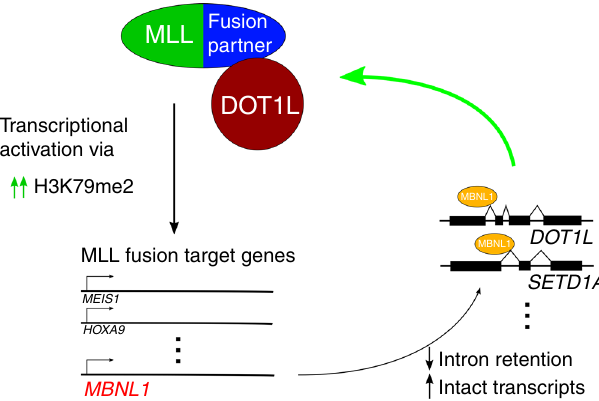
Fig. 8 Working hypothesis for the role of MBNL1 in MLL-rearranged leukemia. The MLL-fusion protein directly promotes MBNL1 gene overexpression, resulting in changes in alternative splicing of target RNA transcripts (typically decreased intron retention and therefore decreased nonsense-mediated decay/increased intact transcripts) which are central to the MLL-rearranged leukemia